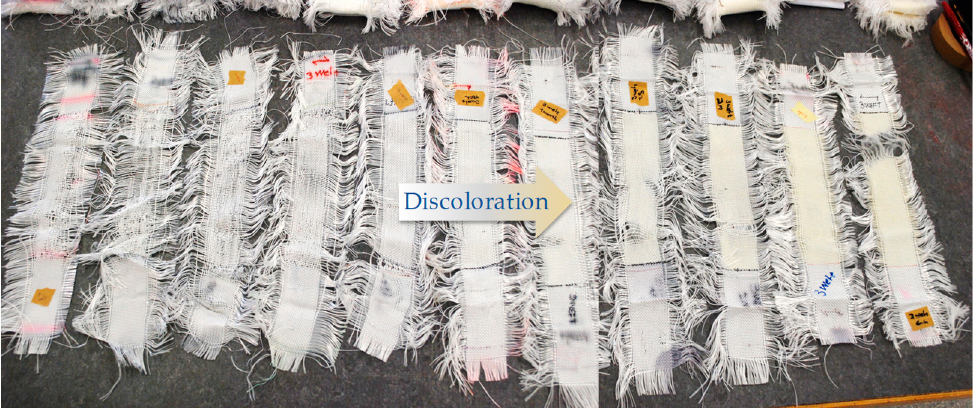
19 of 26 ( c ) Figure 16. Normalized absorbance changes of: ( a ) C=O of carboxylic acid (1688 cm − 1 ); ( b ) crystal- linity index (A1343 cm − 1 /A1376 cm − 1 ); and ( c ) degree of crystallinity (100 × (A973 cm − 1 /A1018